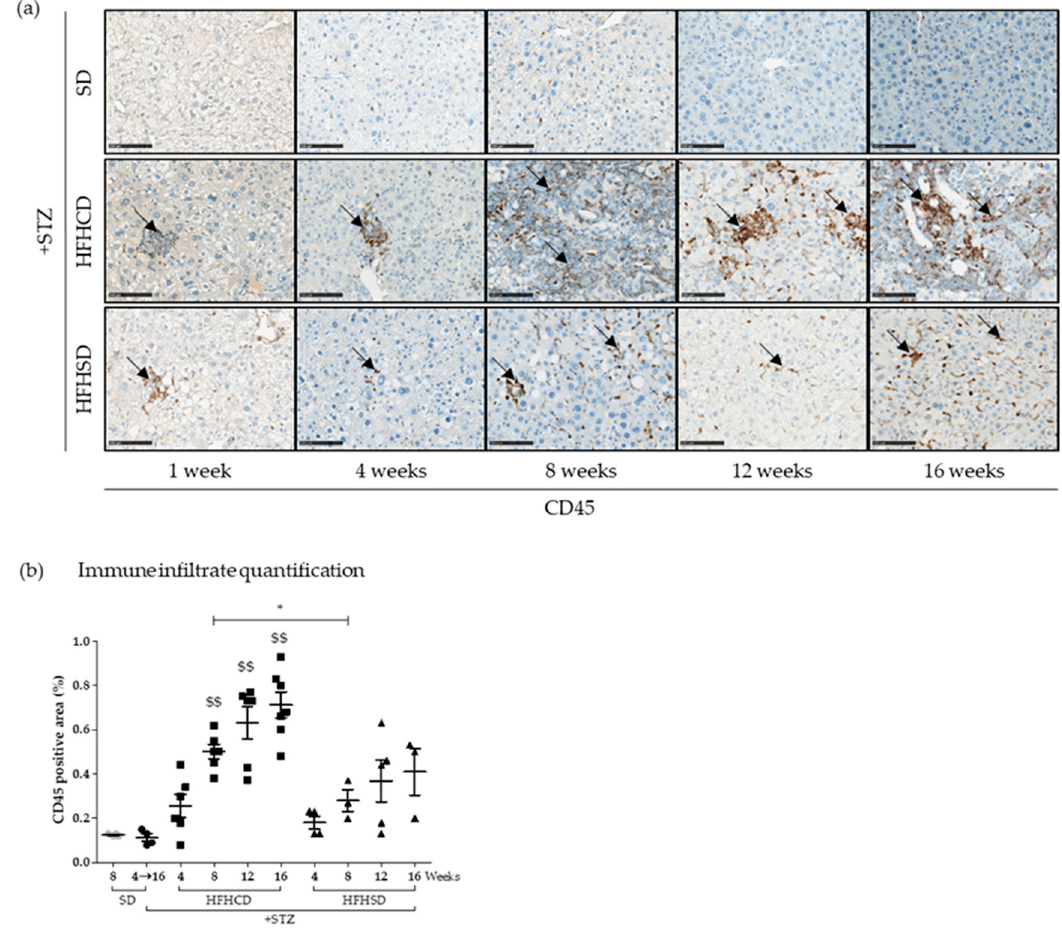
Figure 4. Immune infiltrate presence during hepatocellular carcinoma (HCC) development on NASH background. Healthy or diabetic (STZ) C57Bl6 / J male mice were fed either a SD, a HFHCD or a HFHSD during 1, 4, 8, 12 or 16 weeks. ( a ) CD45 staining of liver sections. Black arrows show CD45 + immune infiltrates. Scale bars: 100 µ m, original magnification × 100; ( b ) quantification of immune infiltrates measured from CD45 positive area. For the graph, each grey dots, black dots, black squares and black triangles represent individuals from the di ff erent groups: healthy mice under SD, diabetic mice under SD, diabetic mice under HFHCD or HFHSD, respectively. $$ p < 0.01 compared diabetic mice under HFHCD or HFHSD to diabetic mice under SD; * p < 0.05 compared diabetic mice under HFHCD to diabetic mice under HFHSD at the same time